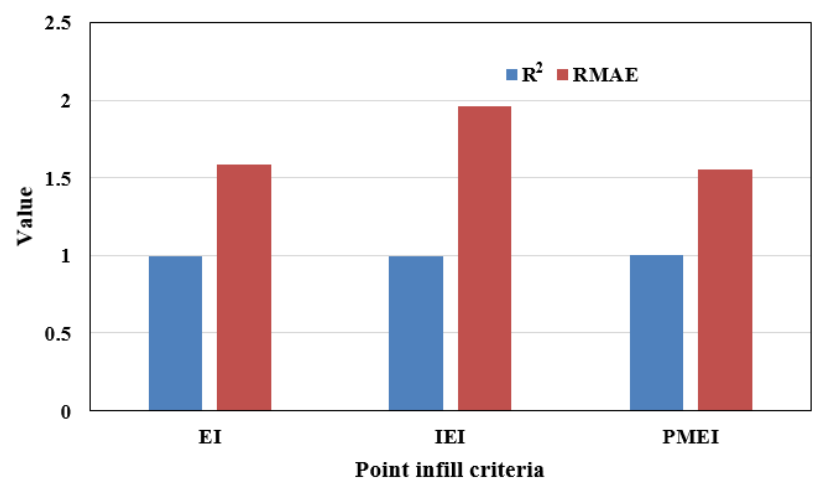
Figure 4. The R 2 and RMAE values of different methods.